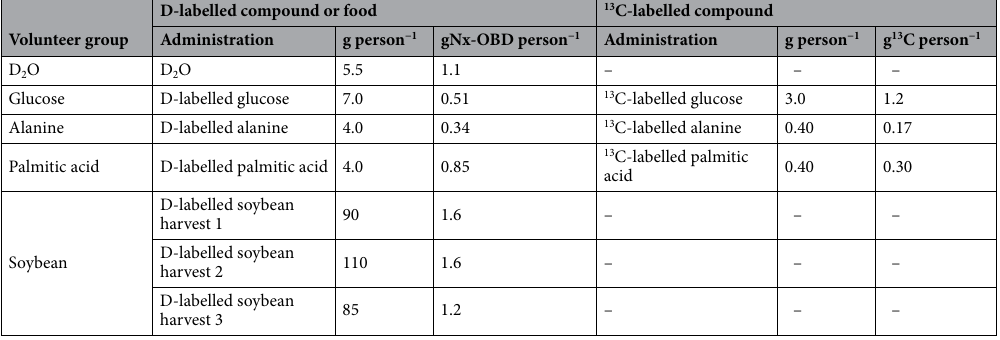
Table 8. Amounts of administered materials. Nx-OBD non-exchangeable organically bound deuterium.